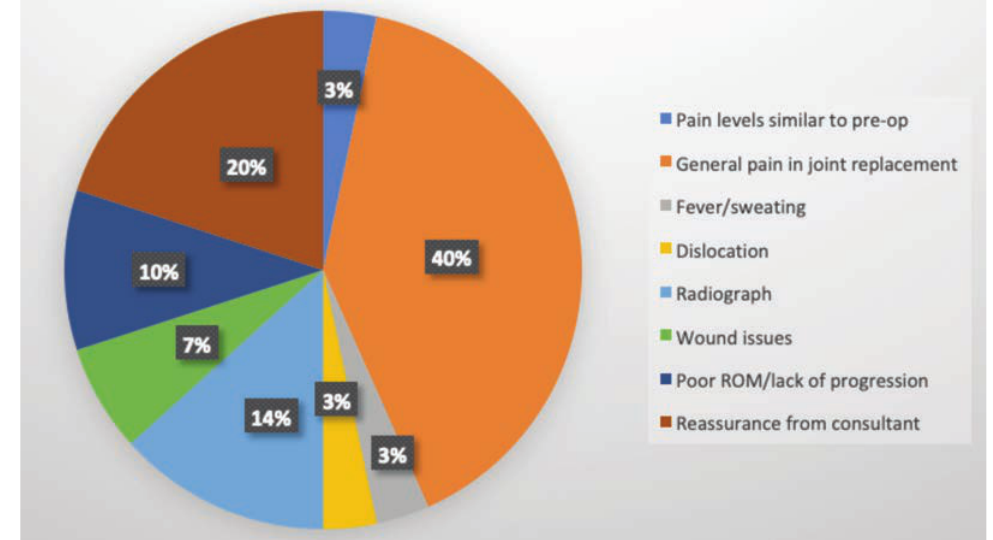
Pie chart highlighting issues that patients feel would need to be addressed in personal Fig. 3: